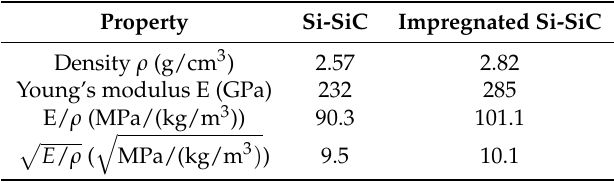
Table 3. Properties of the three laser-sintered and infiltrated